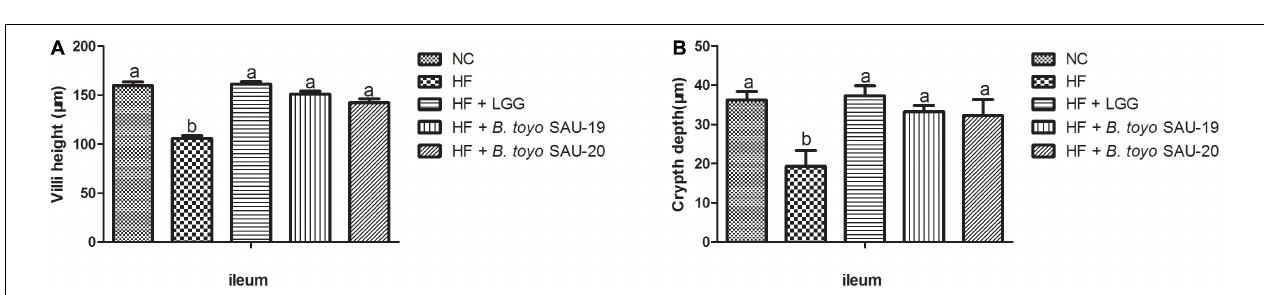
FIGURE 2 | Histopathological observation of in the small intestinal sections of mice fed Bacillus toyonensis SAU-19 and SAU-20 after 35 days. (A) Photograph of histopathological staining in treatment groups (Scale = 20 µ m). (B) Histological inflammation damage scores of ileum section of the small intestine of mice. The values are presented as the mean ± SD. Bars without the same letter differed significantly ( n = 4, P < 0.05). The HF group showed moderate pathological changes characterized by bleed, and moderate inflammation, however, these were mild in the treatment groups. Bleeds are indicated by red arrow and structural damage are indicated by black arrow. NC, mice were administered normal diet + normal saline; HF, mice were fed high fat diet + normal saline; HF + LGG, mice were administered high fat diet + 10 6 Lactobacillus rhamnosus GG; HF + B. toyo. SAU- 19, mice were administered high fat diet + 10 6 Bacillus toyonensis SAU-19 from A. adenophora ; HF + B. toyo. SAU-20, mice were administrated with high fat diet + 10 6 Bacillus toyonensis SAU-20 from A. adenophora .